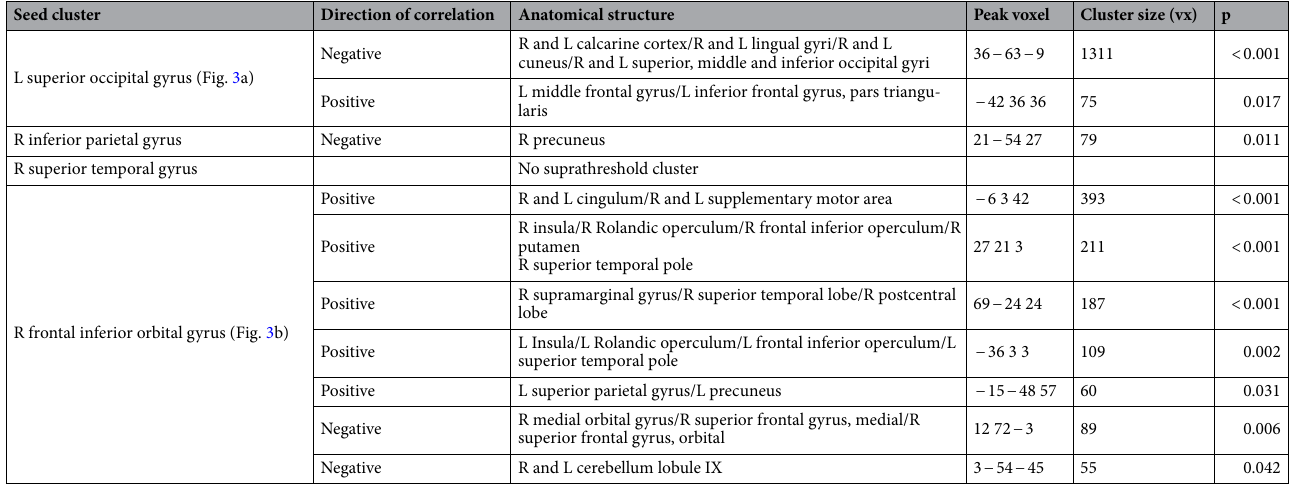
Table 3. Convergent RSFC patterns informative of bilateral TVA voice-preferential responses. Results are shown at a voxel-wise threshold of p < 0.001 and whole brain FWE-corrected at cluster level with a cluster